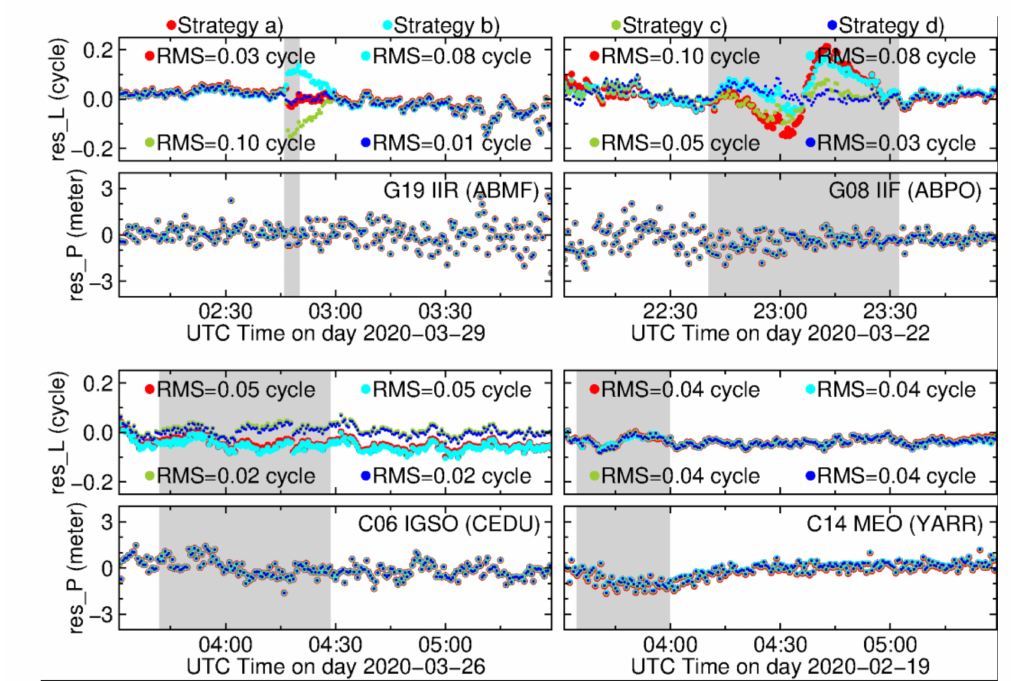
Figure 4. Carrier-phase and pseudorange residuals for different satellite types. Red, cyan, green and blue dots de- note the residuals based on strategies (a), (b), (c) and (d), respectively. The gray zones denote the eclipsing periods of corresponding satellites.